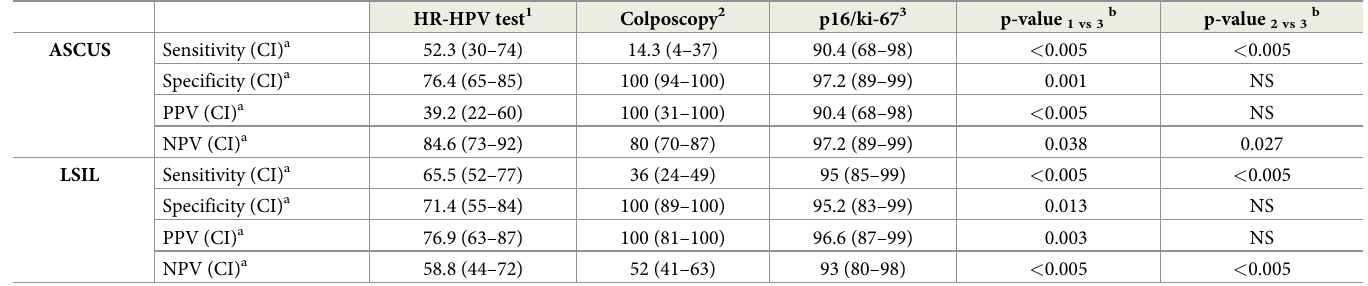
Table 5. Diagnostic ability of HR-HPV test, colposcopy & p16/ki-67 for the detection of CIN2+.